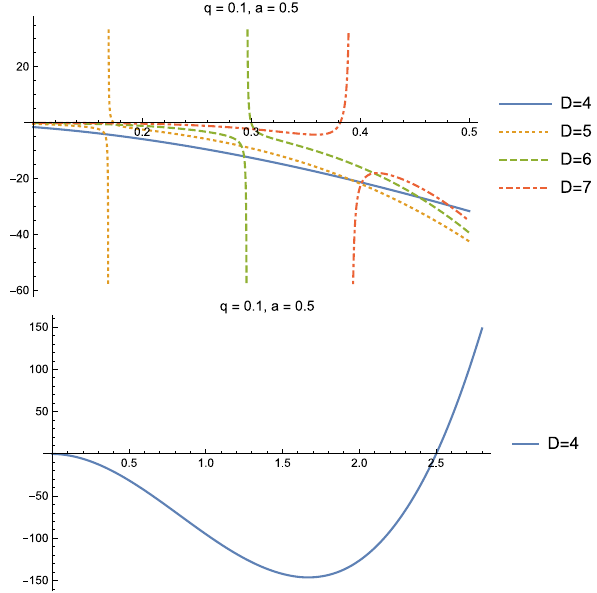
Fig. 9 The heat capacity in D-dimensional TGR as function of r h for different values of q